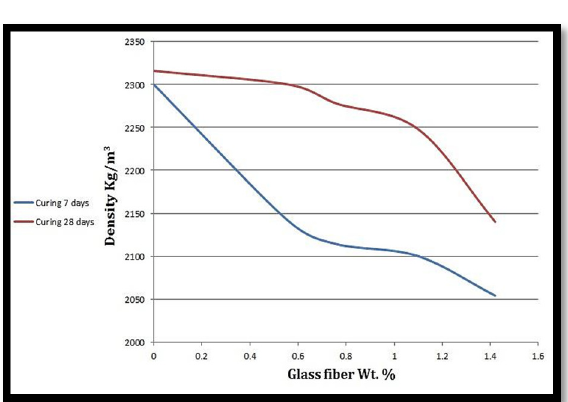
Fig. 2. Effect of random glass fibers addition on the density of mortar without SBR.